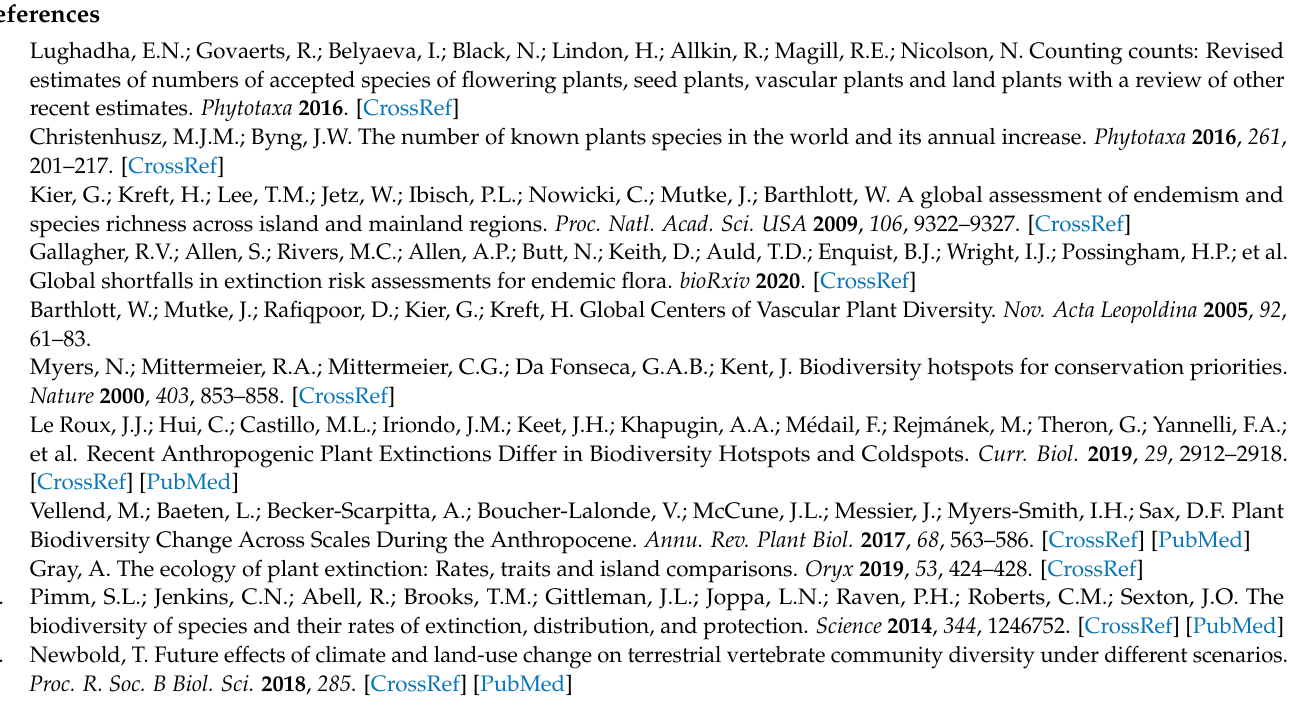
Table S5: Confusion matrix results comparing the IUCN extinction risk status of 238 Greek endemic taxa based on occurrence data [i.e., the ConR and Stevart’s et al. (2019) approach we followed] against control threat categories [data derived from Phitos et al. (1995, 2009)] given as percentages. Regarding the accuracy metric, the confidence intervals are given in parentheses, Table S6: The fourteen Greek endemic plant taxa that should be prioritized in terms of conservation effort based on the EDGE index. EDGE: Evolutionary Distinct and Globally Endangered. ERAB: Extinction risk based on both the IUCN Criteria A and B. CR: Critically Endangered. EN: